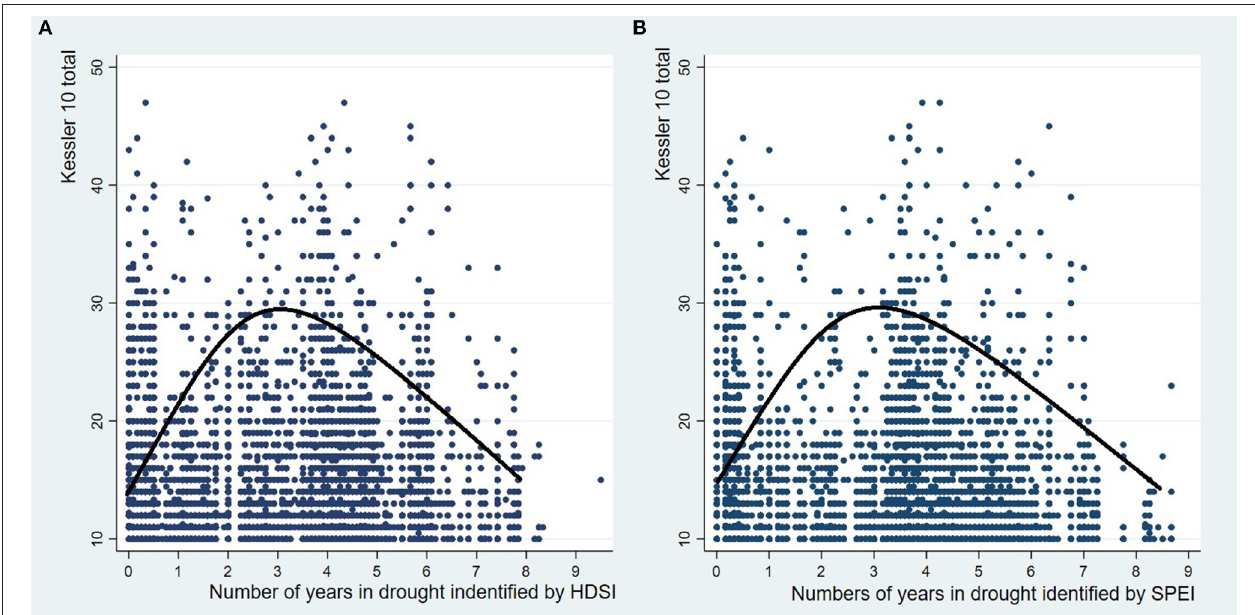
FIGURE 1 | (A) The numbers of years in drought identified by the Hutchinson Drought Severity Index (HDSI) and Kessler-10 (K10); (B) The numbers of years in drought identified by the Standardized Precipitation Evapotranspiration Index (SPEI) and Kessler-10 (K10).